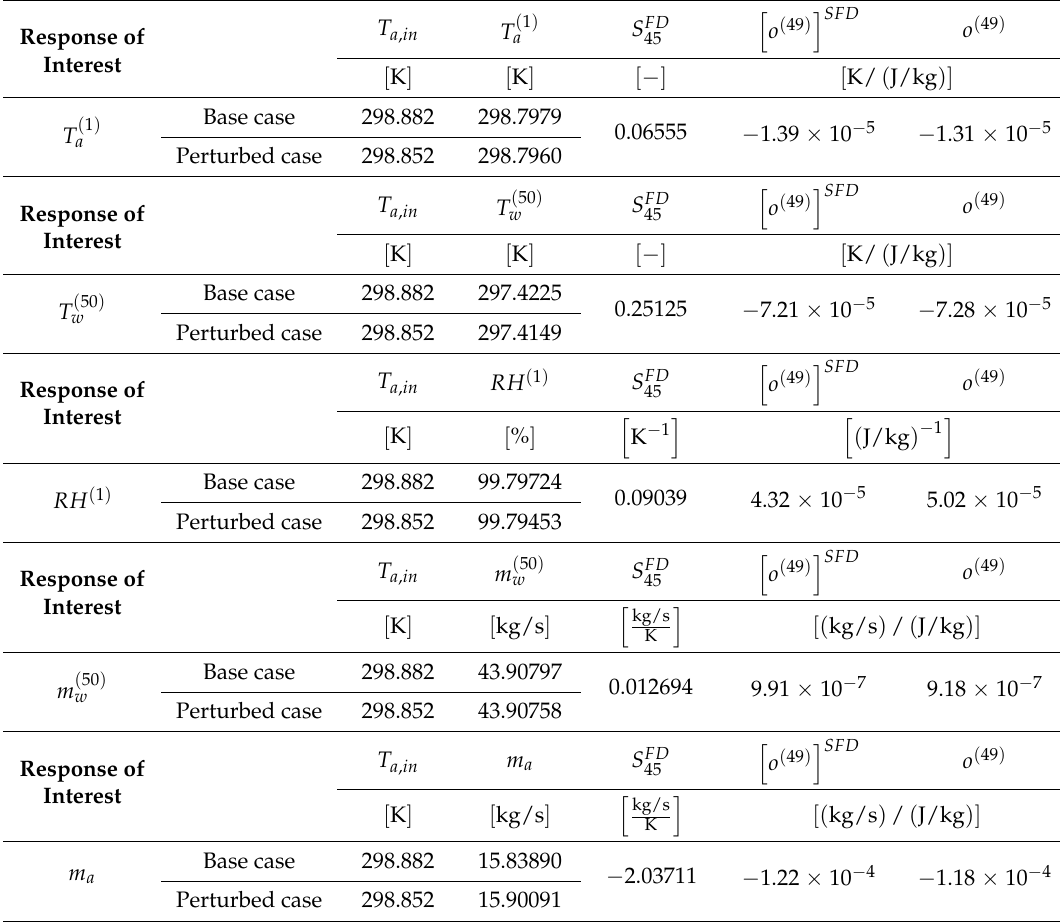
Table E2. Verification Table for adjoint function o ( 49 ) with respect to the responses T ( 50 ) m w and m a